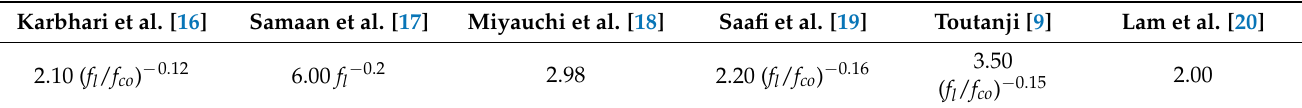
Table 1. Confinement effective coefficient of concrete-filled fiber-reinforced polymer tube (CFFT), k 1. Karbhari et al. [16]